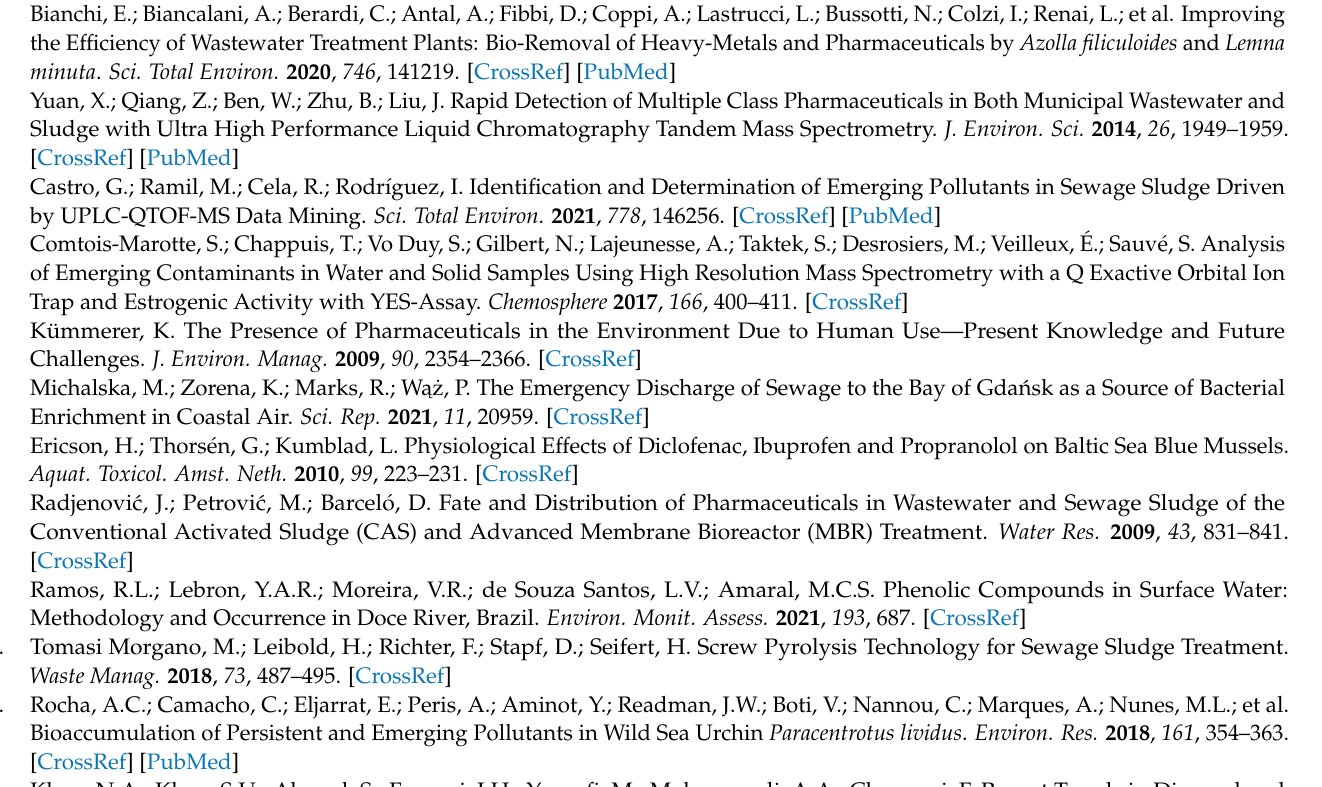
experiment Table S2: Composition of BH medium used in the selective pressure experiment. Table S3: Summary metric of bacterial community analyses in the bioinformatic pipeline. Table S4: Summary metric of bacterial community analyses in the bioinformatic